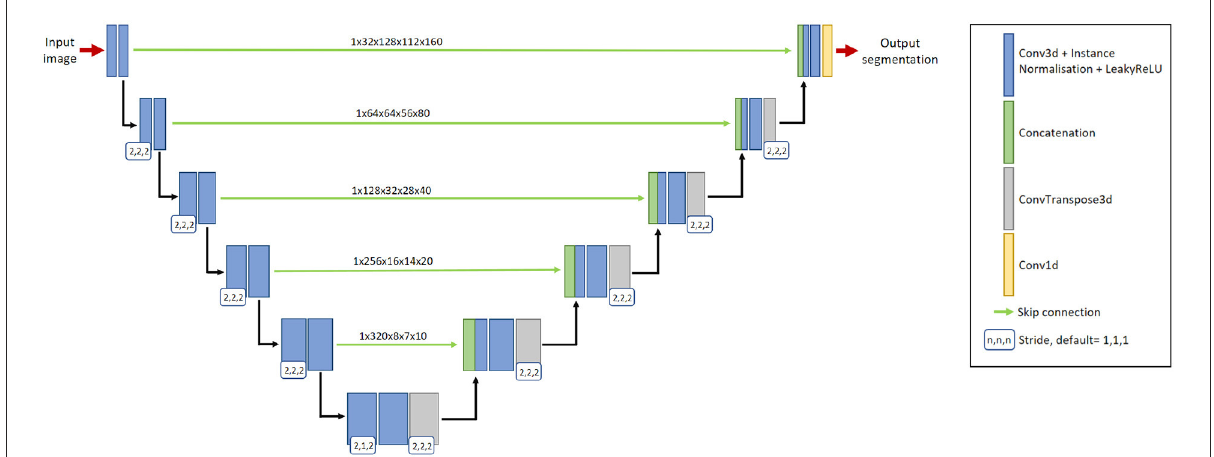
FIGURE2 The 3D nnU-Net architecture for segmenting new lesions. It contains six resolution levels formed from contracting and expanding paths, and skip connections to recover fine-grain detail from the contracting path. The input to the network is a pair of baseline image and follow-up image. The output is the prediction of the new